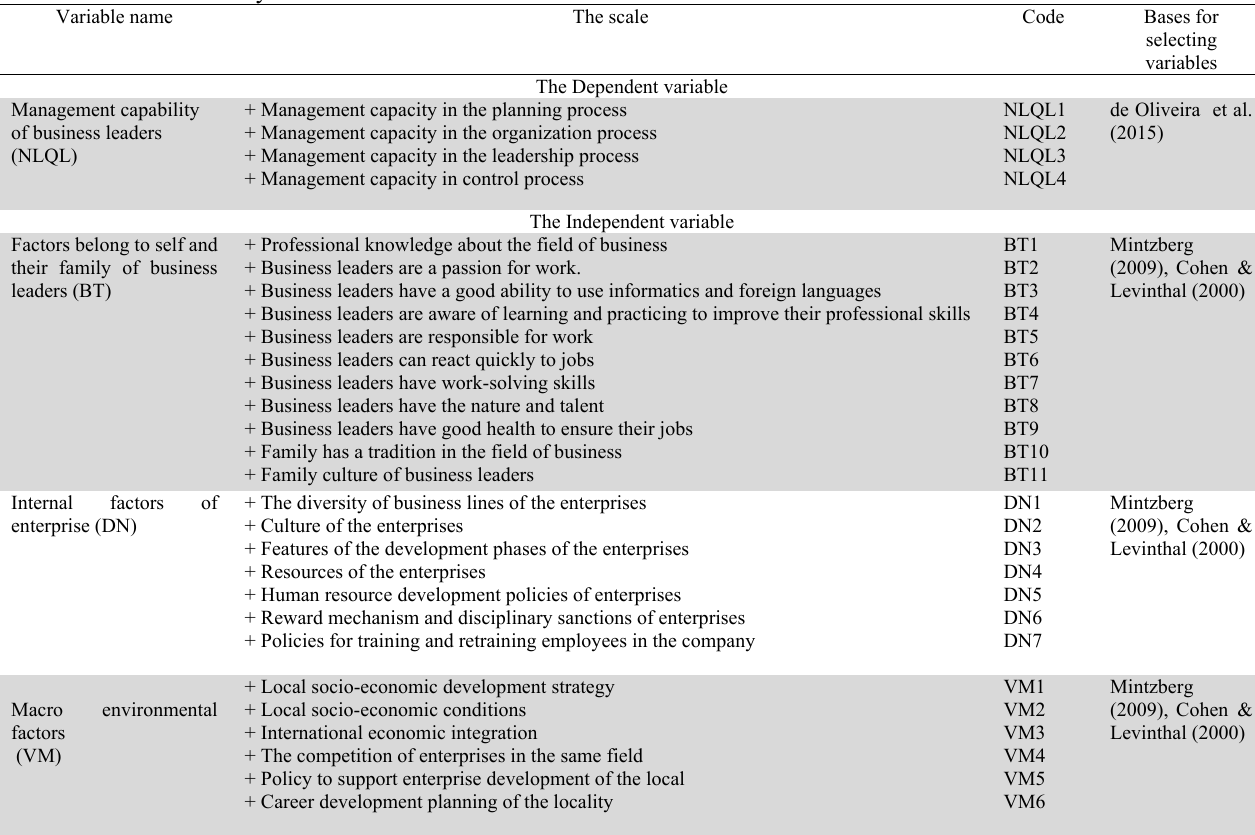
Variables used in the study